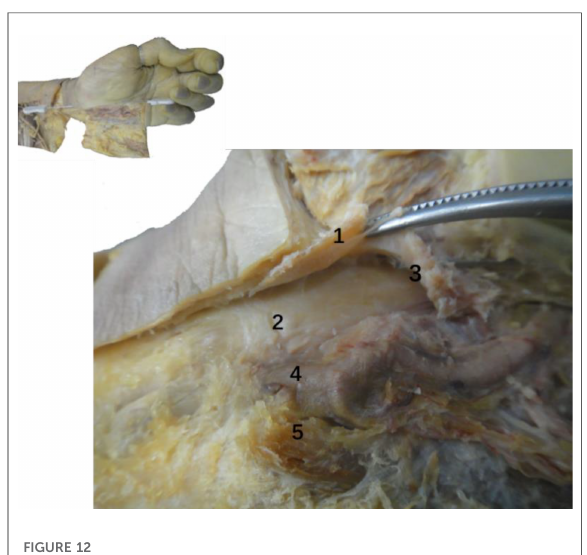
FIGURE 12 The anatomical diagram of the ultrasound-guided needle knife release. 1. Transverse carpal ligament (turned up); 2. Median nerve; 3. Needle tip; 4. Ulnar artery; 5. Ulnar